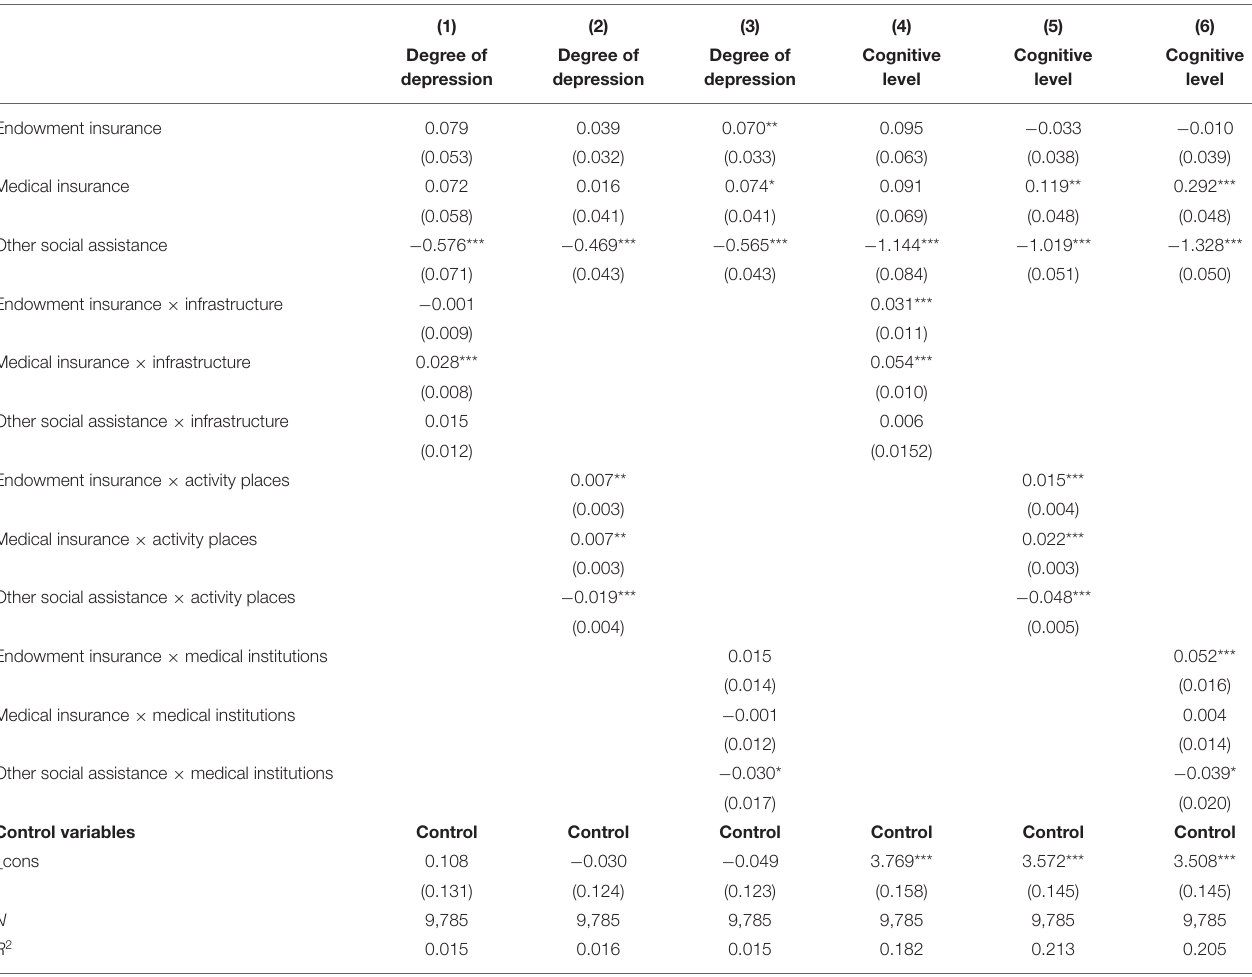
TABLE 4 | Impact of formal social support on mental health of older adults (regulatory effect of community